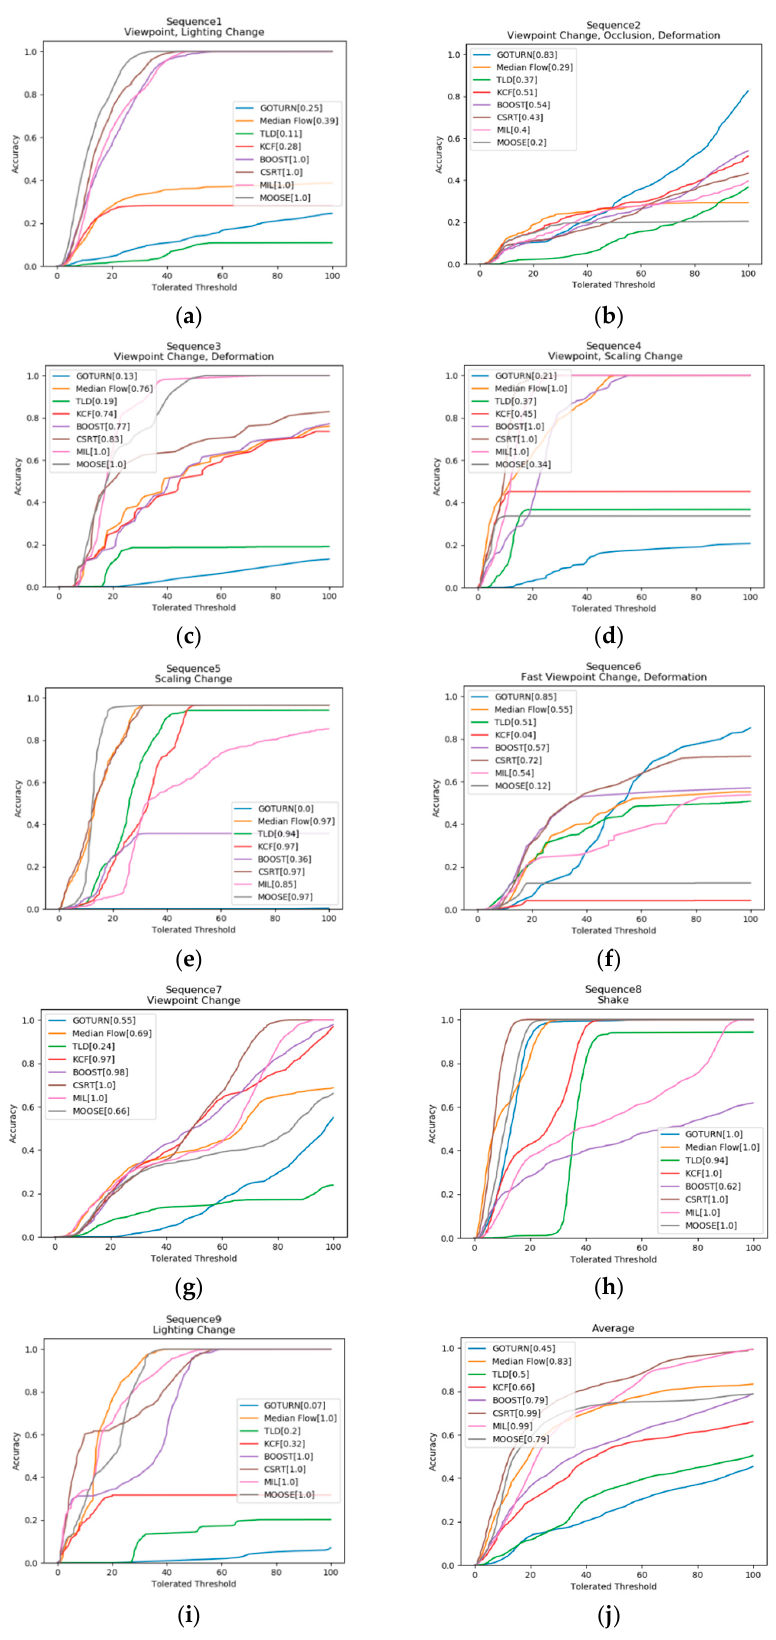
Figure 13. Accuracy comparison of eight trackers on nine 360-degree video sequences. ( a ) Seq.1, ( b ) Seq.2, ( c ) Seq.3, ( d ) Seq.4, ( e ) Seq.5, ( f ) Seq.6, ( g ) Seq.7, ( h ) Seq.8, ( i ) Seq.9, ( j ) Overall average